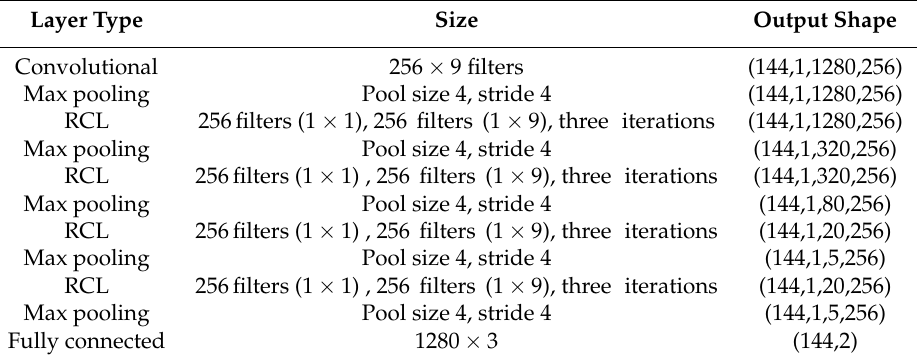
Table 1. The proposed recurrent convolutional neural network (RCNN)